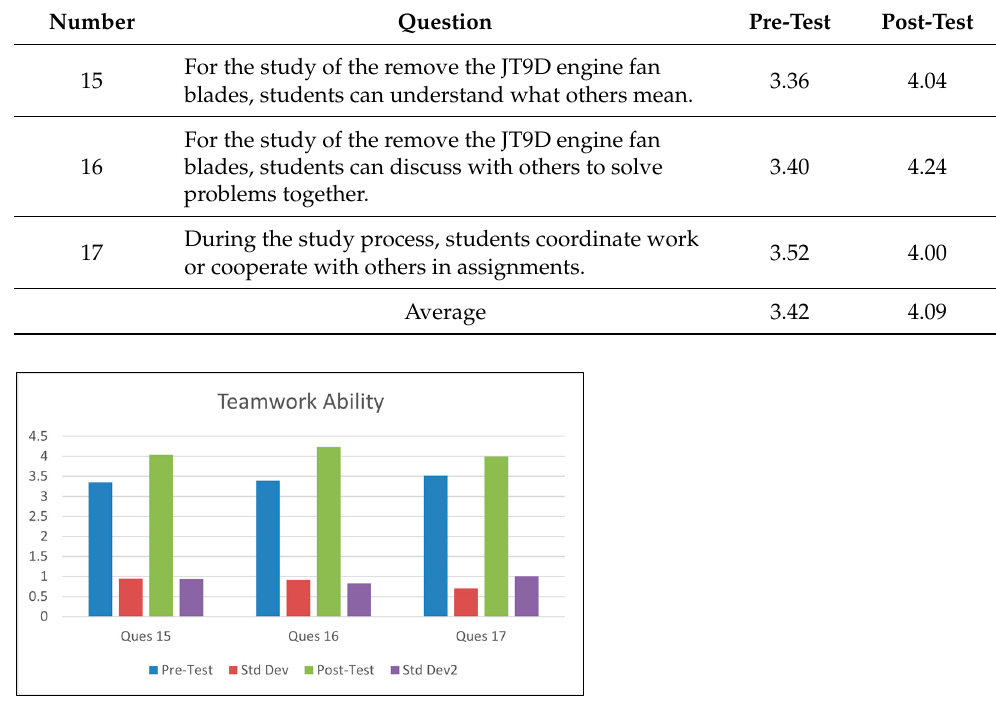
Figure 10. Students’ teamwork ability in the previous test and the post-test.